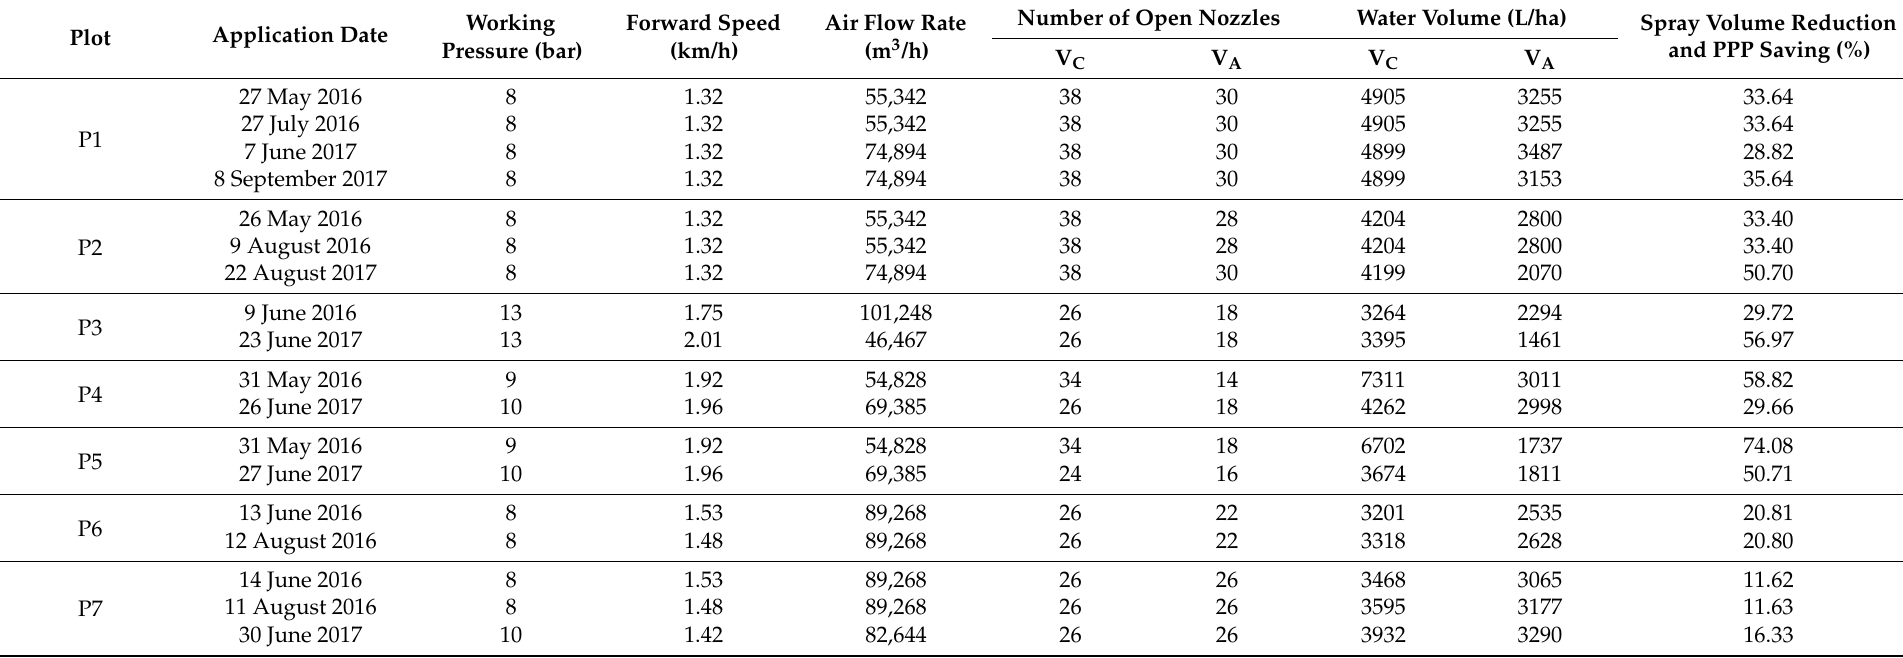
Table 3. Operative characteristics of spray